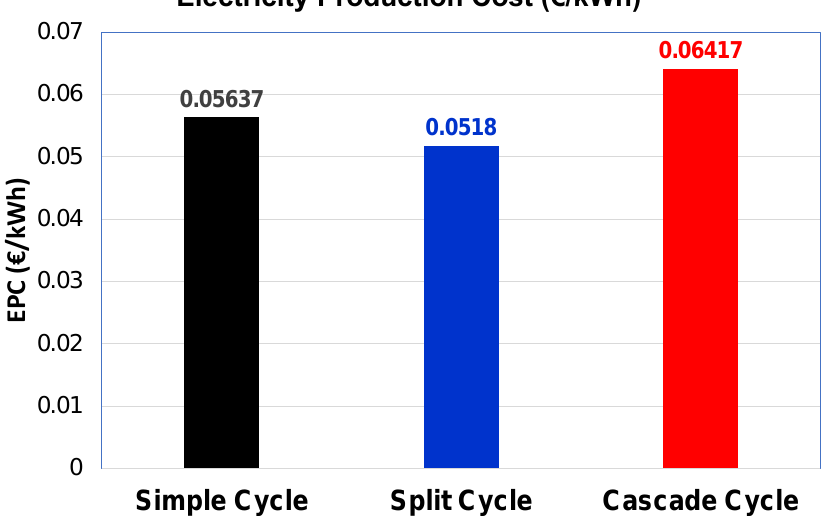
Figure 8. Theoretical results for the Electricity Production Cost (EPC) of the simple supercritical CO 2 cycle, the split supercritical CO 2 cycle, and the cascade supercritical CO 2 cycle.